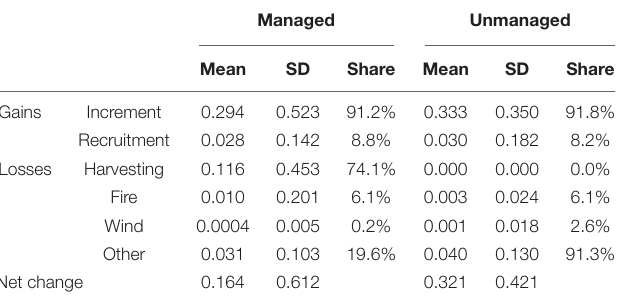
TABLE 2 | Gains (increment, recruitment) and losses (harvesting, mortality) in basal area (m 2 ha − 1 year − 1 ).